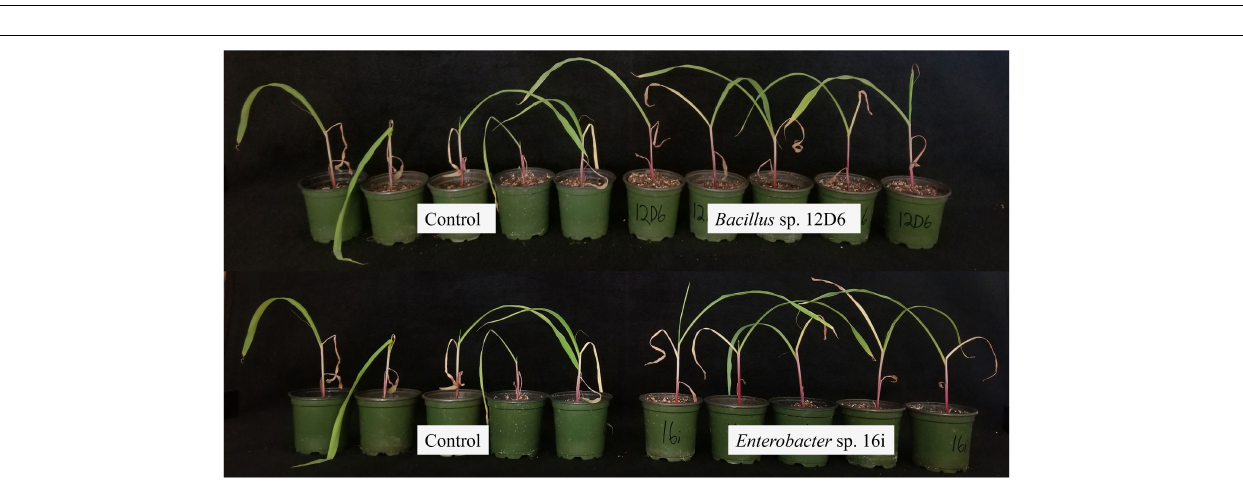
FIGURE 1 | Wheat seedlings treated with plant growth-promoting rhizobacteria (PGPR). Bacillus sp. 12D6 (middle) and Enterobacter sp. 16i (right) demonstrated the delayed onset of drought symptoms versus control (left) in wheat seedlings after exposure to 7 days of continuous water deficit.